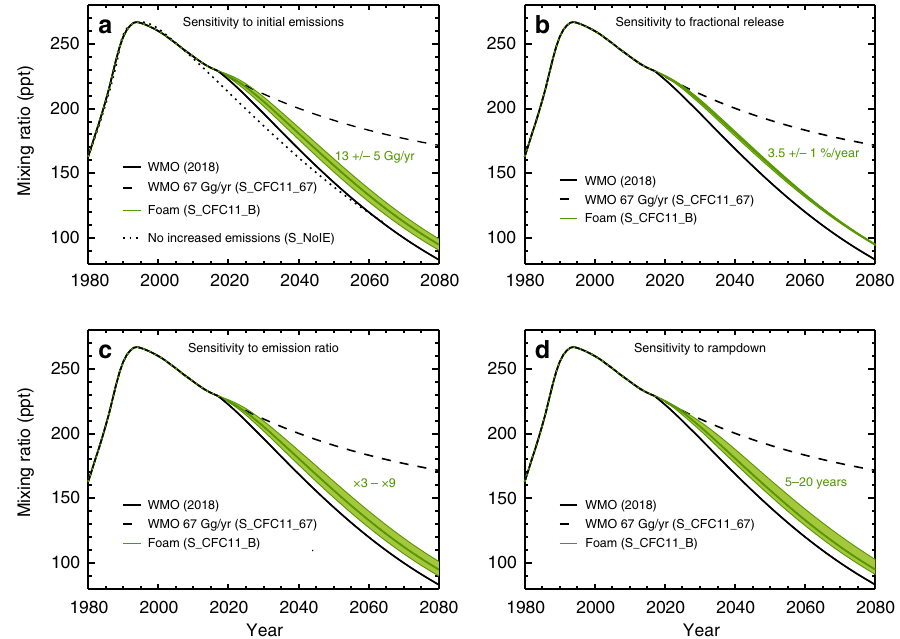
Fig. 2 Past and potential future concentrations of CFC-11. As Fig. 1 but for CFC-11 volume-mixing ratio (ppt). a Four scenarios including the World Meteorological Organisation (WMO) (2018) 20 baseline scenario (solid black line) and an assumption of constant 67 Gg yr − 1 emissions (dashed line, S_CFC11_67). Also shown is a scenario with decreasing emissions from an estimate of the 2002 bank (dotted line, S_NoIE). Emissions based on box model simulations for unreported CFC-11 production for foam use are shown in green (solid line, S_CFC11_B). The green shading indicates the sensitivity range for S_CFC11_B for initial emissions ranging from 8 to 18 Gg/yr (see Methods for assumptions). b Similar to panel a , for WMO (2018) baseline and S_CFC11_67 scenarios with green shading showing sensitivity of scenario S_CFC11_B for fractional release ranging from 2.5 to 4.5%/year. c Similar to panel b , and showing sensitivity to emission ratios from ×3 to ×9. d Similar to panel b , and showing sensitivity to rampdown of new production between 5 and 20